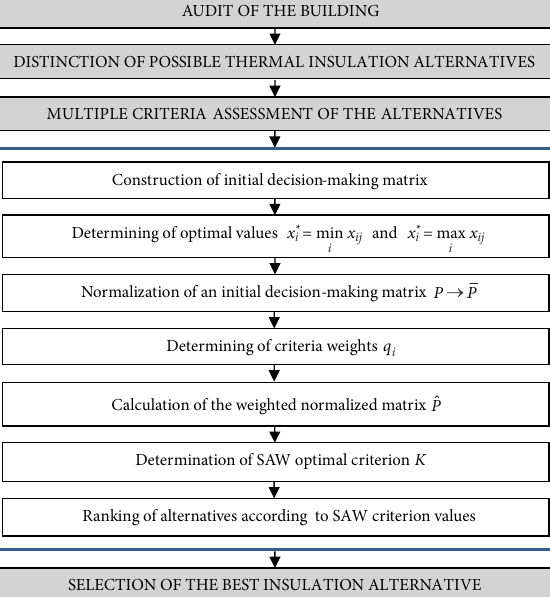
Fig. 1. Model for selection of the thermal